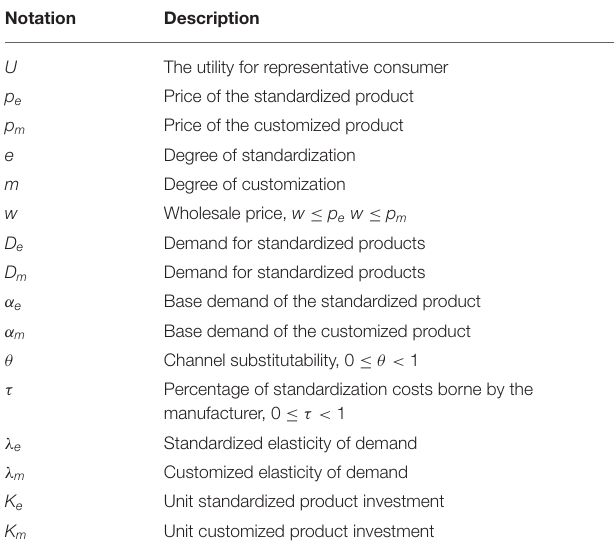
TABLE 1 | Summary of